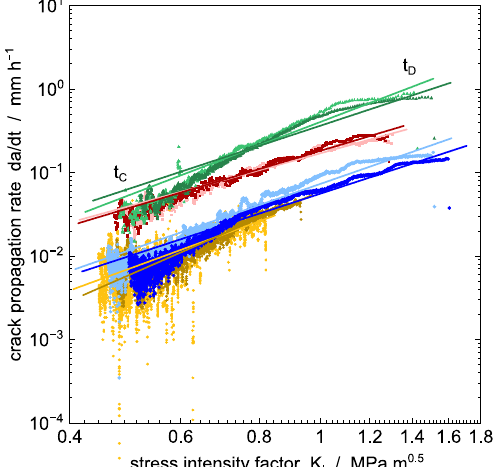
Figure 8. Crack propagation rate from static loading as a function of stress intensity factor. Solid lines represent a power function fit of experimental data with Equation (2). Different environmental media at a temperature of 40 °C are plotted: PFL-FR 2323 (yellow), PFL-FR 2344 (green), distilled water (blue), and 2 wt% aq. Arkopal N100 (red). Table 4. Fitted exponents 𝑚 for the two individual experiments per medium from power law be- havior and critical stress intensity factor in MPa m (cid:2868).(cid:2873) as a crucial value for transition from craze– crack propagation to macroscopic plastic deformation.